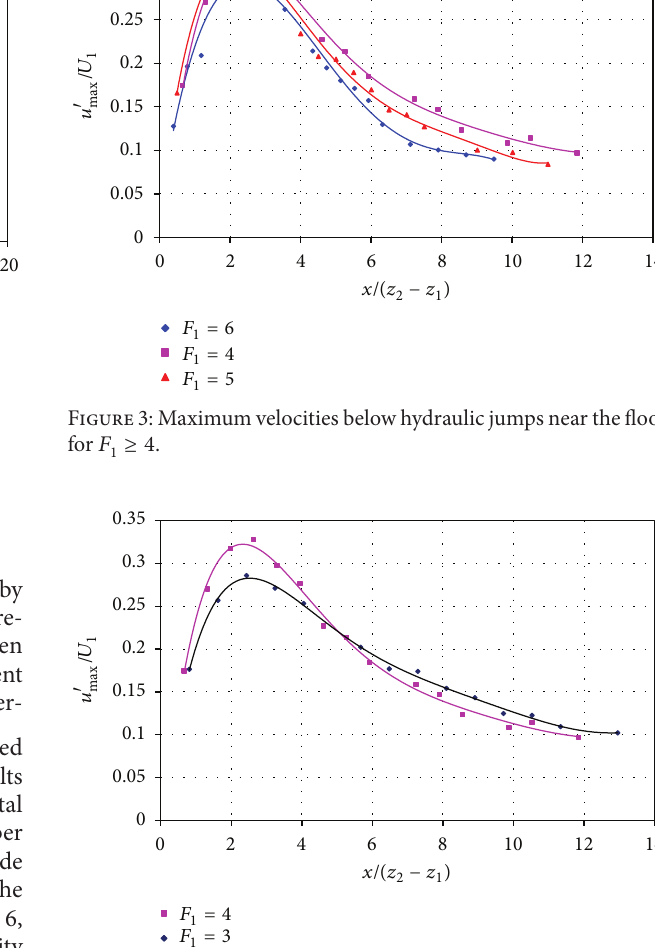
Figure 4: Maximum velocities below hydraulic jumps near the floor for 𝐹 1 ≤ 4